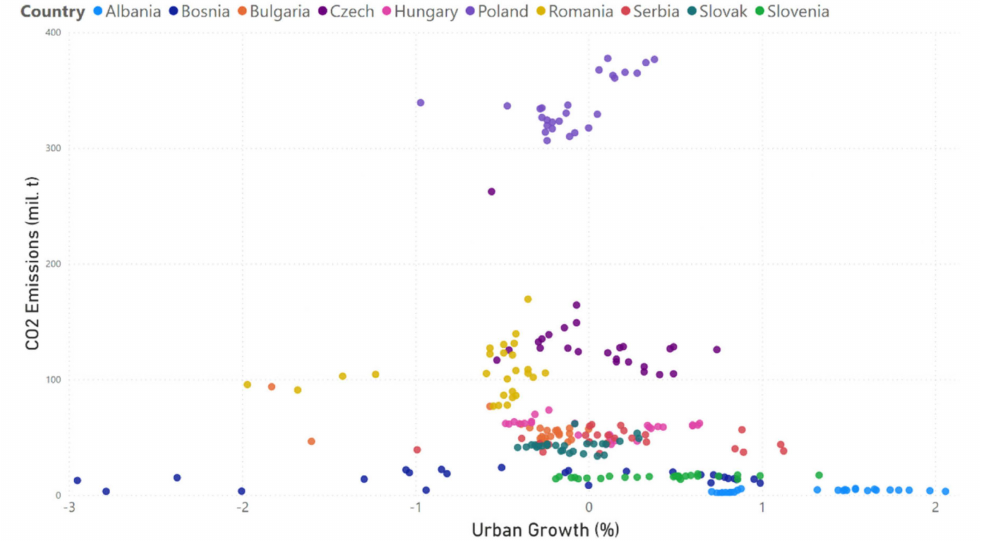
Figure 2. Urban growth and CO 2 emissions—Country Clusters (1990–2015). For most of the country clusters, the data points show steady values regardless of the value of the urban growth, with two exceptions: (a) Poland, that clearly displays a linear increase of the CO 2 emissions when the urban growth rate is increasing; (b) Czech Republic that shows a descending trend of the emissions, while the urban growth rate is increasing. The correlation between carbon emissions and sectorial energy-related features is explained in Figure